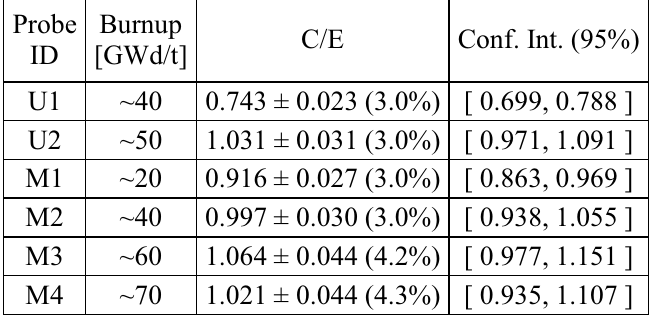
Table III.: Comparison of predicted and measured absolute neutron emission rates